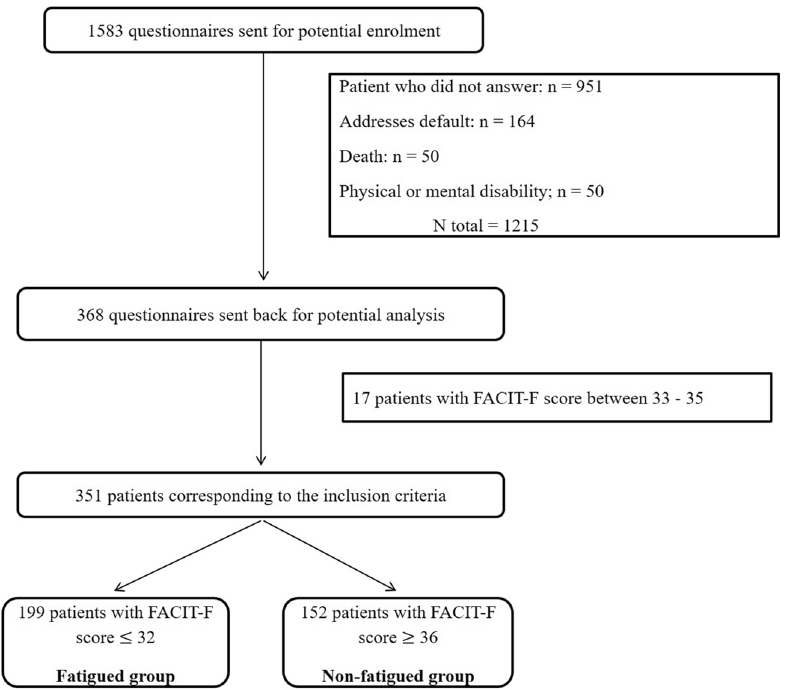
Figure 1. Flowchart of the study